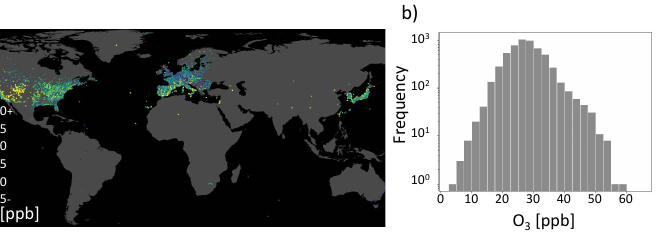
Figure 1. Geospatial air quality benchmark dataset (AQ-Bench). ( a ) Measurements of the target on a map projection. It is the average ozone from 2010 to 2014 of the AQ-Bench dataset and is given in ppb (parts per billion). ( b ) Histogram of the average ozone values in the AQ-Bench dataset